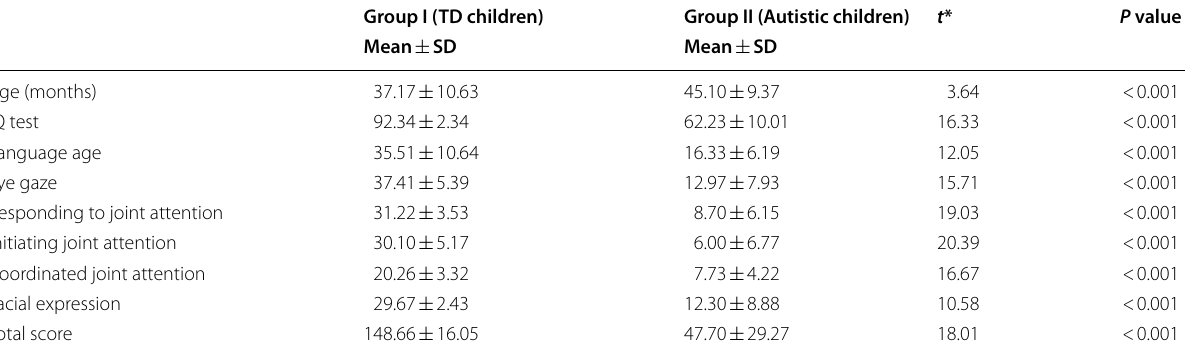
Data expressed as mean